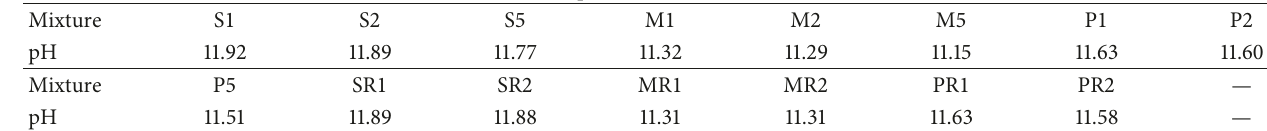
Figure 4: Concentration of Pb in eluates from matrices. Table 6: The pH of eluates from matrices.